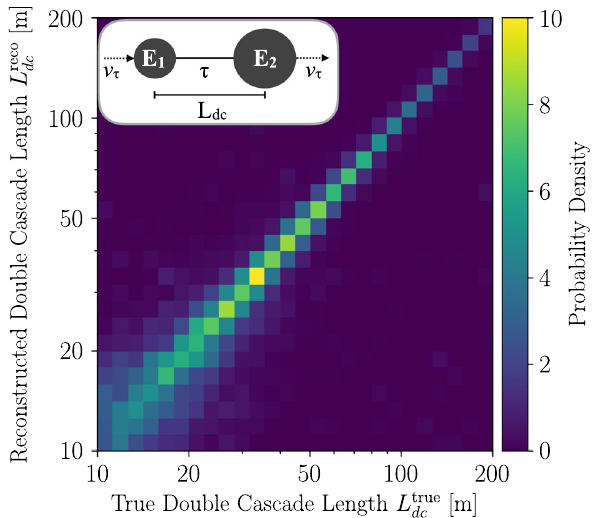
Fig. 1 Length resolution for simulated tau neutrinos classified as dou- ble cascades for the best-fit spectrum [19]. With increasing length, the resolution improves while the event expectation drops. The inlay shows a schematic of a ν τ CC interaction producing a double cascade with associated reconstruction